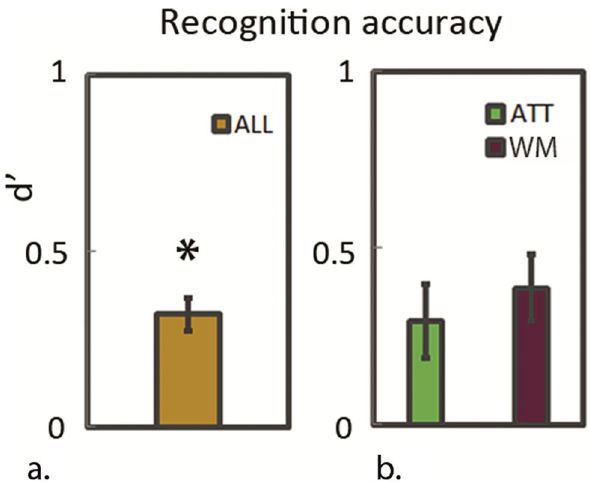
Figure 3. Recognition task accuracy scores. Accuracy scores on the post-hoc recognition task are plotted as d’ scores across conditions ( a ) and separated for colour-arrays that had previously been shown during the ATT or the WM condition ( b